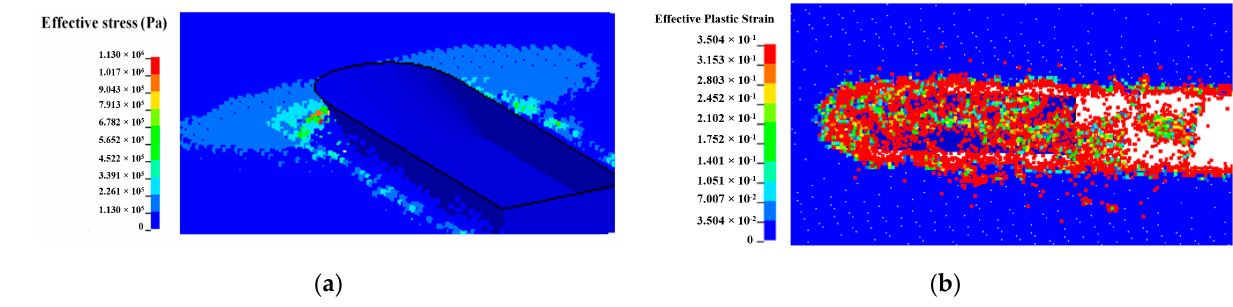
Figure 4. Icebreaking pattern of the present numerical simulation, where ( a ) is the stress distribution of level ice and ( b ) is the open channel in the icebreaking process (contours of plastic strain).